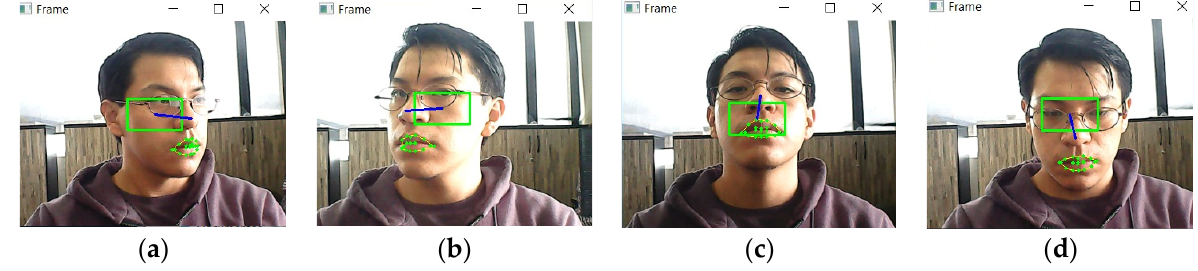
Figure 1. EMKEY noise detection for generating cursor movement to ( a ) right, ( b ) left, ( c) up and ( d ) down.